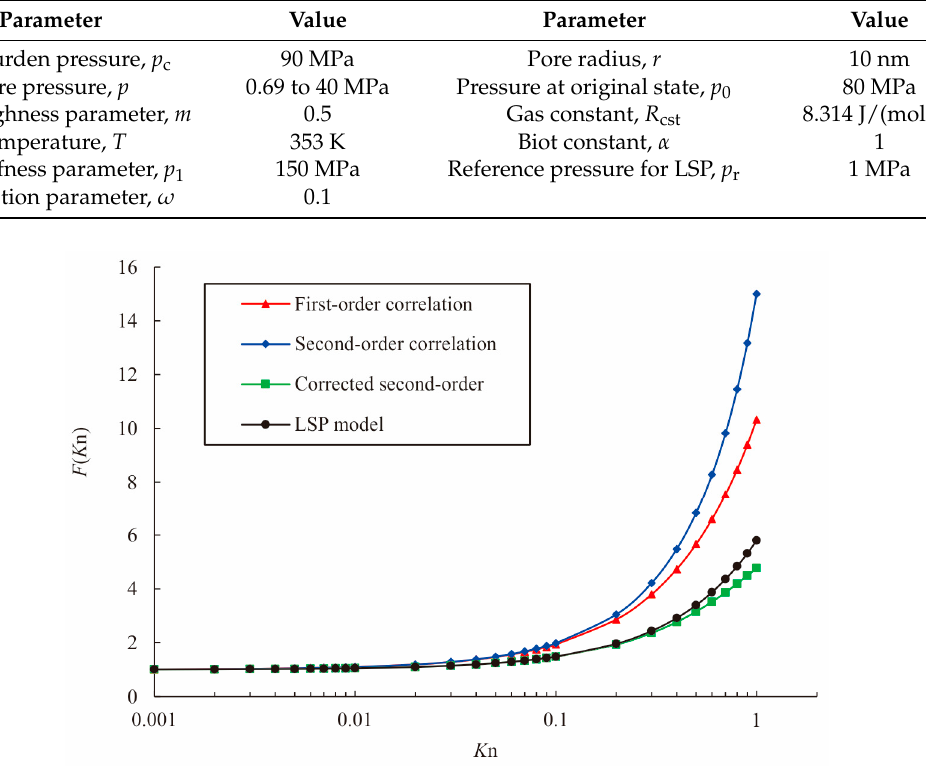
Figure 5. Model comparison from different slip boundary conditions.